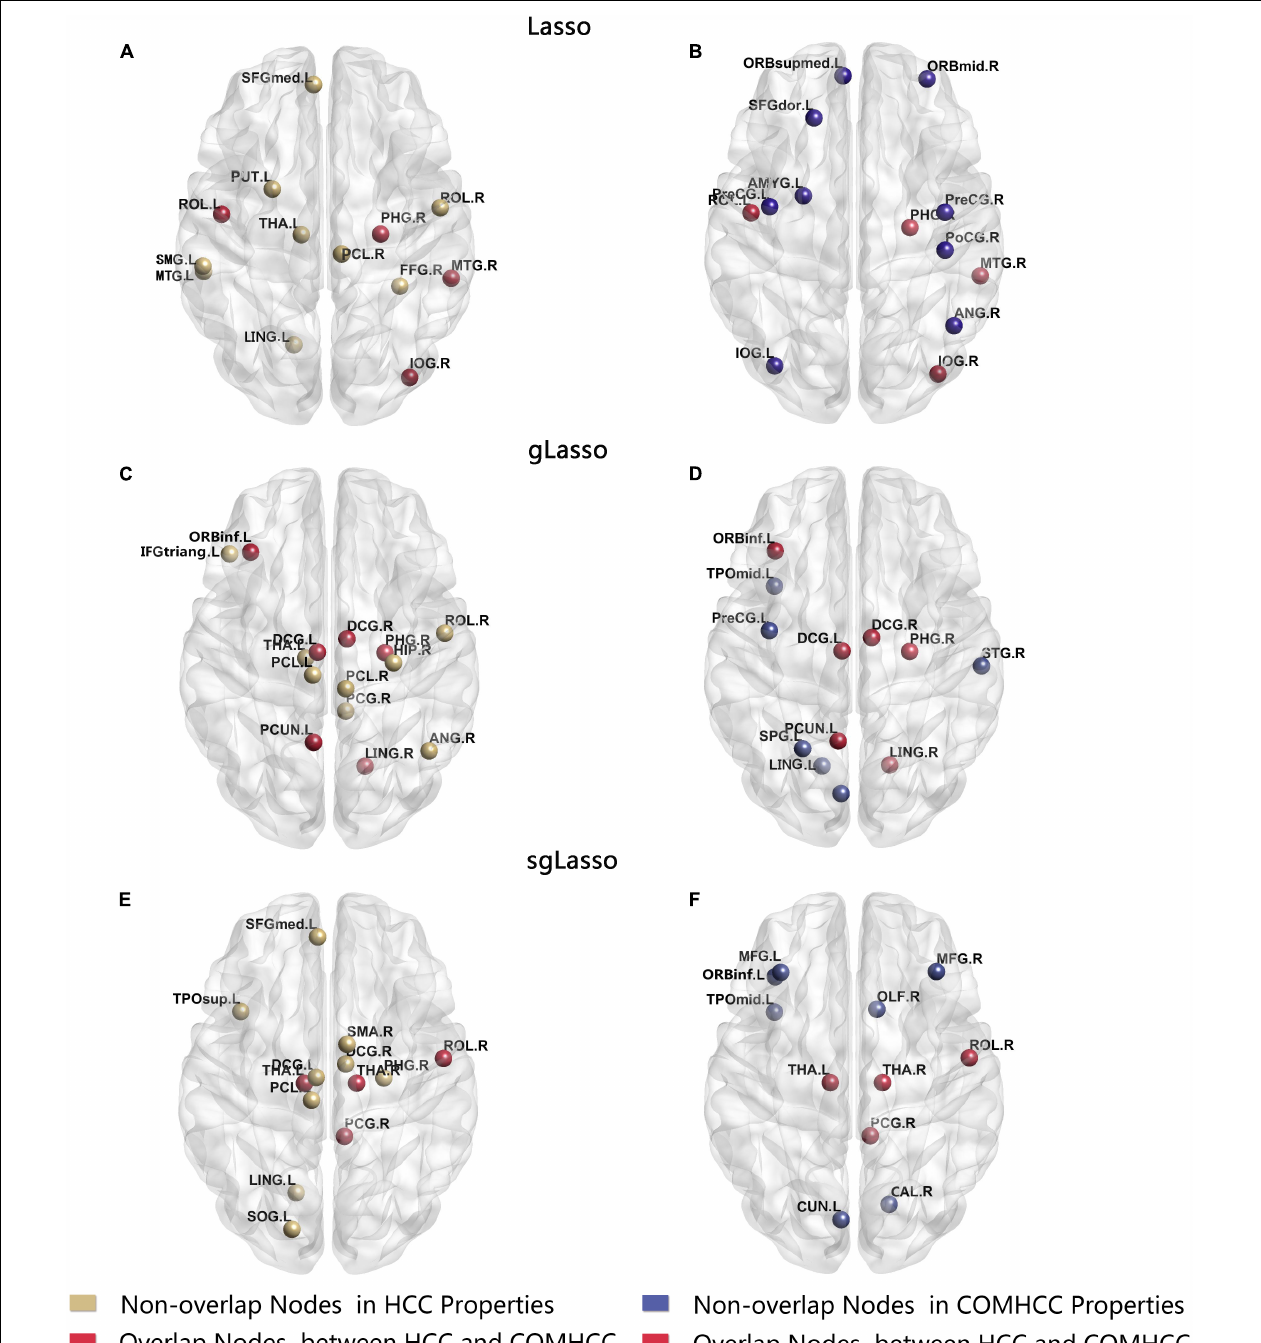
FIGURE 7 | Abnormal brain regions were mapped onto the cortical surfaces using BrainNet viewer software. (A) Abnormal brain regions calculated by HCC properties in lasso method. (B) Abnormal brain regions calculated by COMHCC properties in lasso method. (C) Abnormal brain regions calculated by HCC properties in gLasso method. (D) Abnormal brain regions calculated by COMHCC properties in gLasso method. (E) Abnormal brain regions calculated by HCC properties in sgLasso method. (F) Abnormal brain regions calculated by COMHCC properties in sgLasso